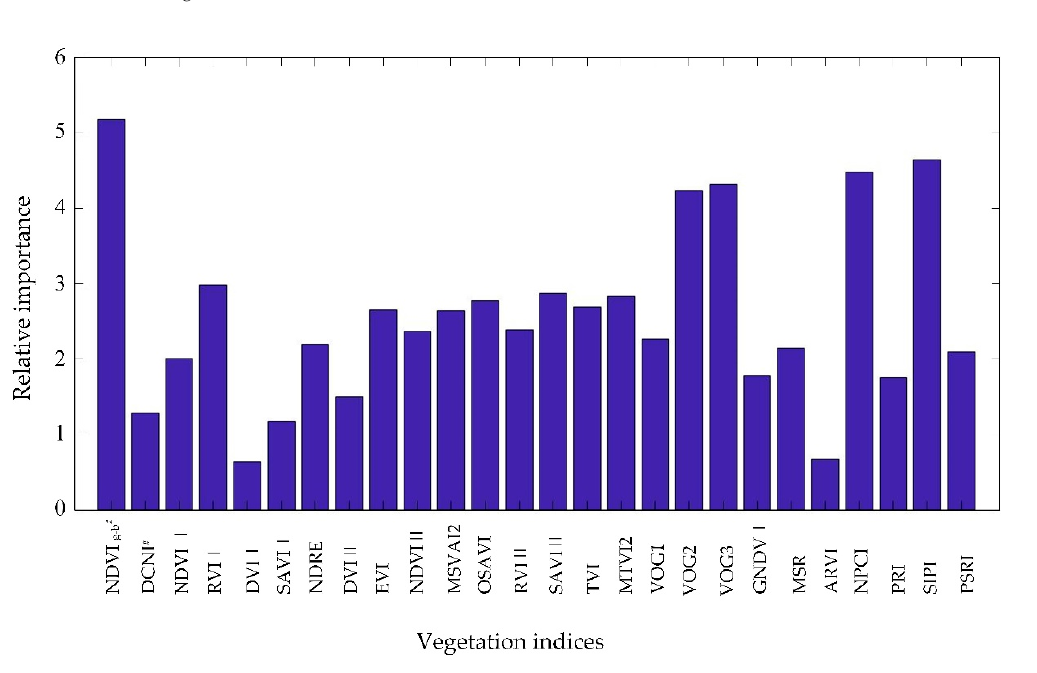
Figure 4. Feature importance of vegetation indices based on the random forest algorithm.